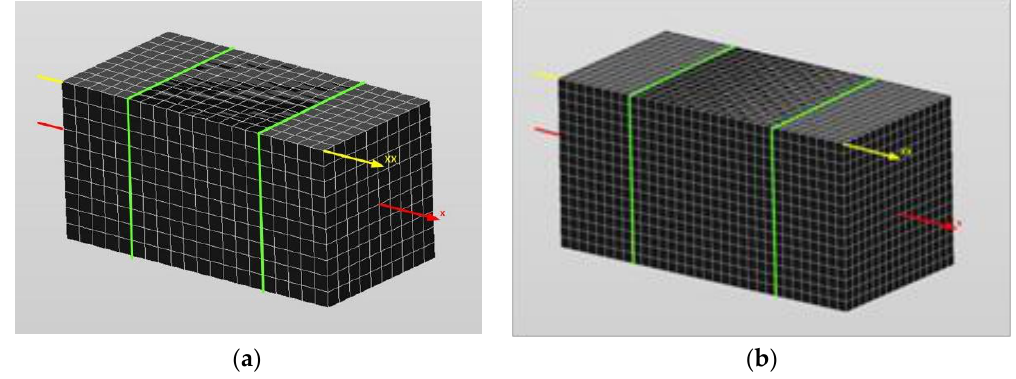
Figure 8. A typical single cubic model (−4 mm ≤ x, XX ≤ 4 mm) (between two green lines) including the outside of the cube (−8 mm ≤ x ≤ −4 mm and 4 mm ≤ x ≤ 8 mm) in the VIEM. ( a ) A single cubic model (−4 mm ≤ x, XX ≤ 4 mm) with 1000 elements (Model_10 × 10 × 10) (between two green lines) including the outside of the cube (−8 mm ≤ x ≤ −4 mm and 4 mm ≤ x ≤ 8 mm). 1000 elements are used for the discretization of the outside of the cube; ( b ) a single cubic model (−4 mm ≤ x, XX ≤ 4 mm) with 4096 elements (Model_16 × 16 × 16) (between two green lines) including the outside of the cube (−8 mm ≤ x ≤ −4 mm and 4 mm ≤ x ≤ 8 mm). 4096 elements are used for the discretization of the outside of the cube.